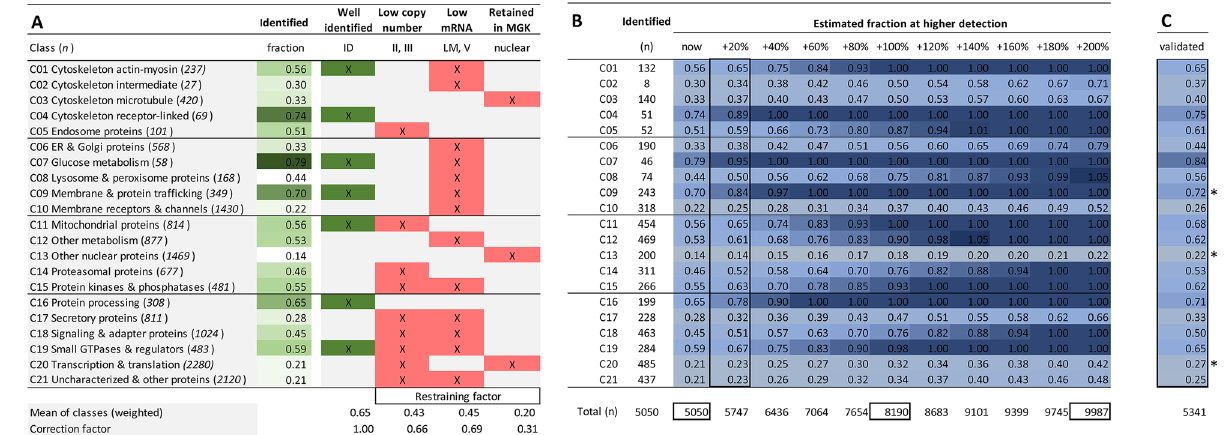
Figure 7. Restraining factors per function class and prediction model of full platelet proteome. Analysis of non- identified proteins ( n = 9,721) from the relevant, combined PLT/MGK transcriptome per function class. Full dataset is provided in Suppl. Table 2. ( A ) Fraction of identified proteins in green. Well-identified classes with fractions > 0.55 labeled as ID. Indicated in red are each of three restraining factors per class: (i) over- represented low copy number (areas II-III in Fig. 5D), (ii) low mRNA level (area V, LM = low mRNA > 45%); (iii) retainment in megakaryocyte (peri)nucleus upon platelet shedding. Bottom: means of identified fractions (weighted for the presence of multiple factors); and correction factor in comparison to ’well-identified’. ( B ) Based on identified proteins ( n = 5,050), modelled prediction of increased identification of missing proteins per class at higher proteomic detection. Shown per class are fractions of total relevant transcripts (heatmapped), and total expected proteins (bottom line). ( C ) Validation of prediction model based on novel proteome with 5,341 identified